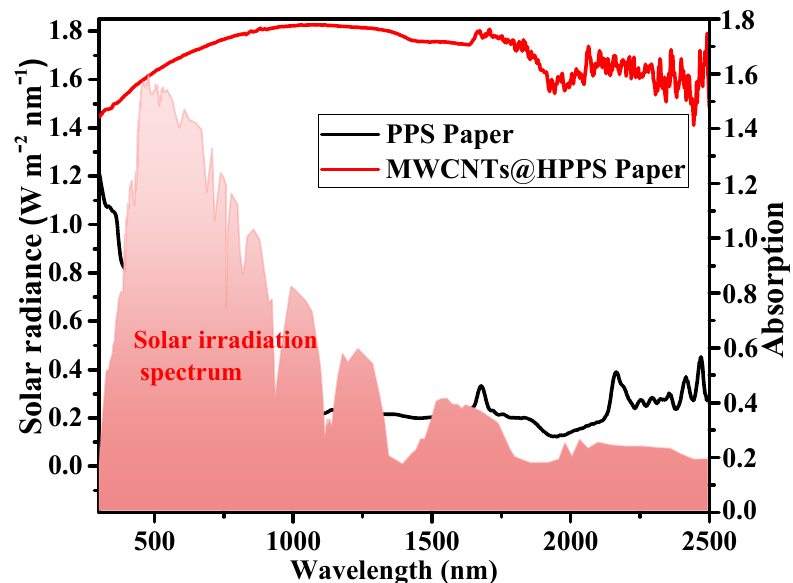
Figure 6. The absorption spectra of PPS and MWCNTs@HPPS papers.